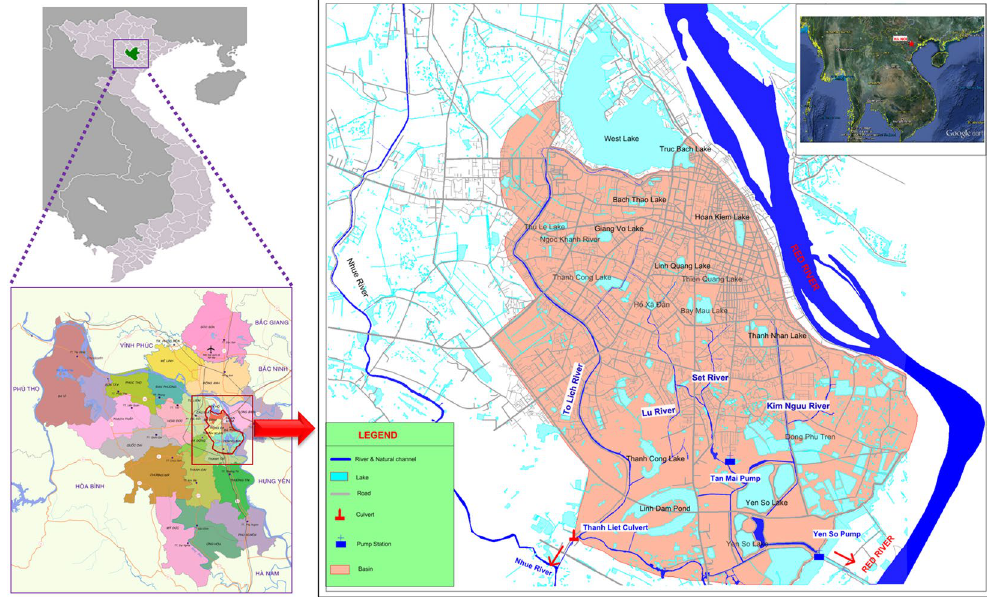
Figure 1. Location map of Hanoi central area for the flood inundation simulation (Source: Southeast map is obtained from Google Earth, Administrative divisions of Hanoi is obtained from Wikipedia, https:// en.wikipedia.org/wiki/Hanoi, The RAW data of central area map is from project of “Collection and Analysis of Data Related to Flood and Inundation in Hanoi Capital” Kha Dang-Dinh re-edited this